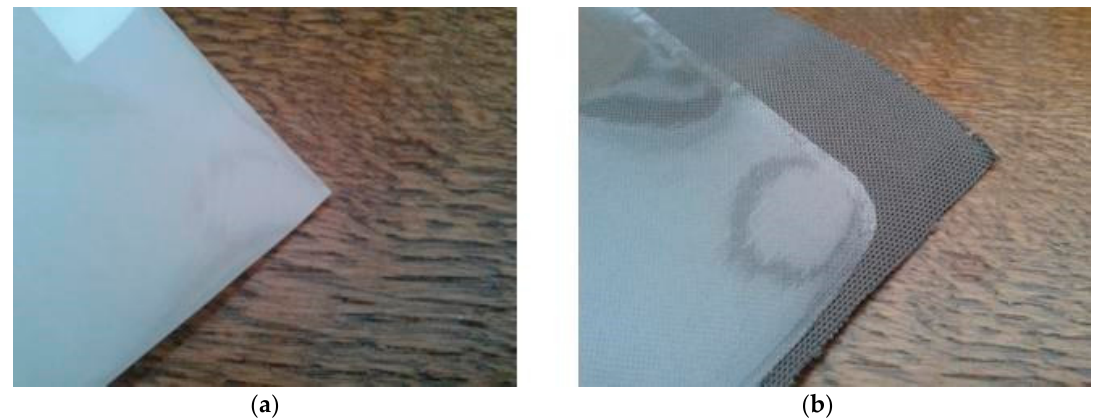
Figure 4. The textile substrate covered with PU (polyurethane) ( a ) or acrylate ( b ) to smoothen the textile roughness towards nm-range.